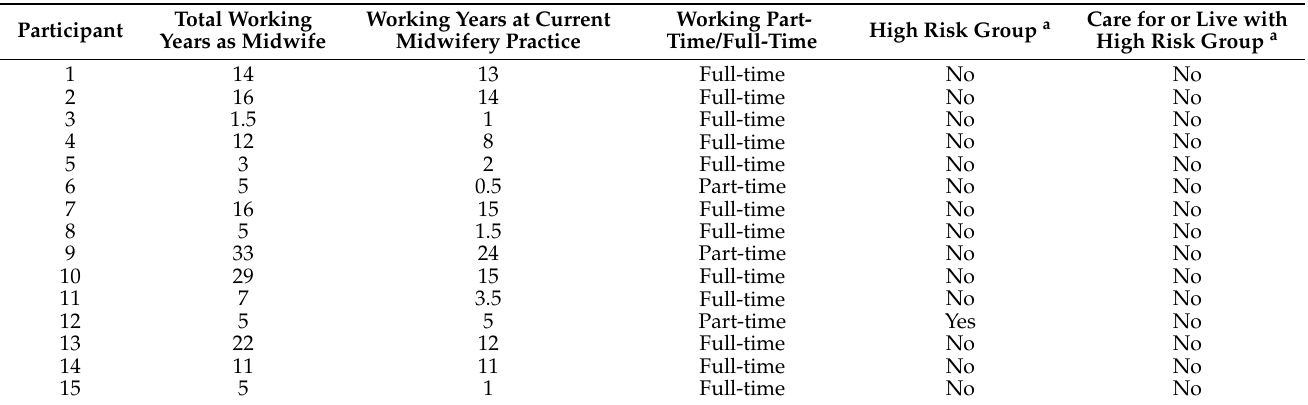
Table 3. Background information